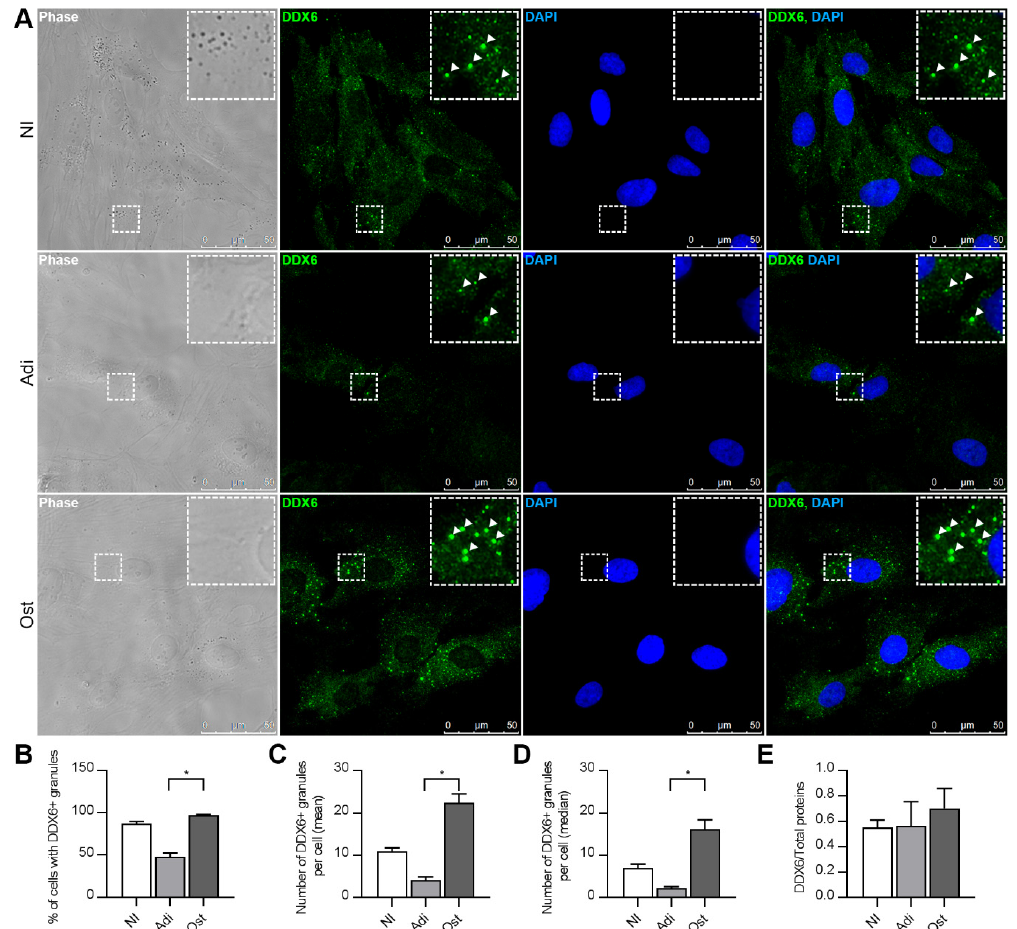
Figure 4. The DDX6 granule distribution changed upon adipogenic and osteogenic differentiation induction. ( A ) Results from the immunofluorescence analysis with microscopy showing DDX6 localization in the hASCs maintained in noninduction medium (NI) or induced to adipogenesis (Adi) or osteogenesis (Ost) for 24 h. Notably, the granular pattern was changed in cells stimulated to differentiate. Nuclei were stained with DAPI. ( B ) Percentages of the cells that contained DDX6 granules in hASCs maintained in noninduction medium (NI) or induced to adipogenesis (Adi) or osteogenesis (Ost) for 24 h. ( C ) Mean number of DDX6 granules per hASC maintained in noninduction medium (NI) or induced to adipogenesis (Adi) or osteogenesis (Ost) for 24 h. ( D ) Median number of DDX6 granules per hASC maintained in noninduction medium (NI) or induced to adipogenesis (Adi) or osteogenesis (Ost) for 24 h. ( E ) Quantification of DDX6 protein expression (by Western blotting) in hASCs maintained in noninduction medium (NI) or induced to adipogenesis (Adi) or osteogenesis (Ost) for 24 h. ( B – D ) Samples from three different donors were analyzed ( n = 3); standard error of the mean (SEM); Kruskal-Wallis test and Dunn’s multiple comparisons post-test: * p < 0.05.